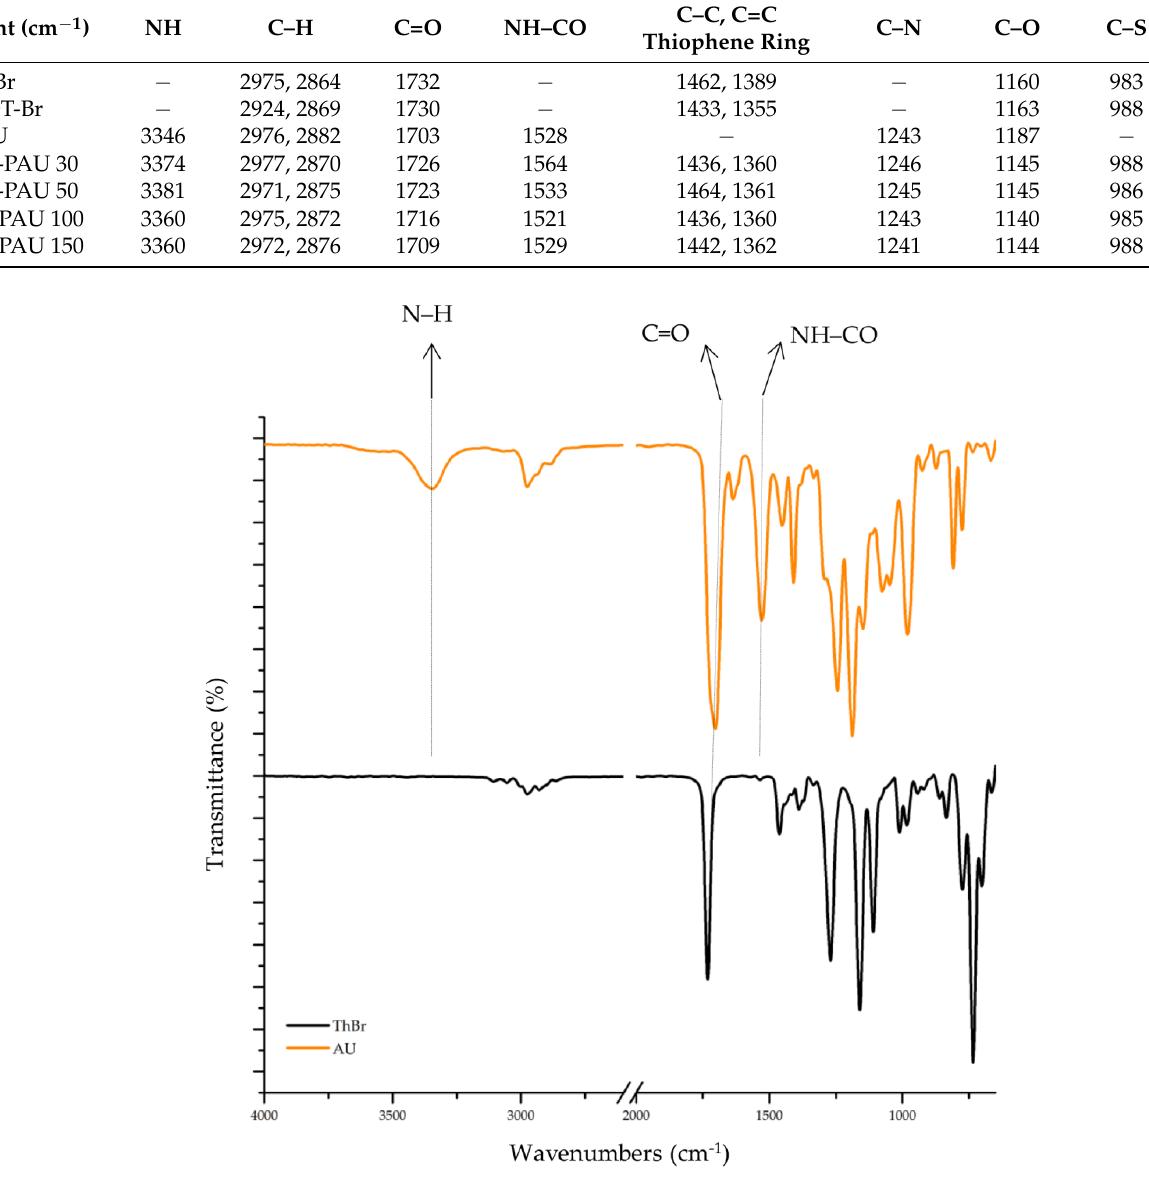
Figure 1. FTIR spectra of monomers ThBr and